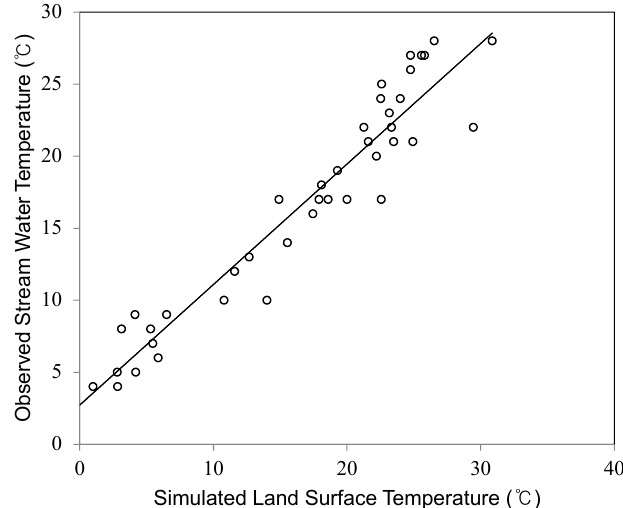
Figure 8. Comparison of trends between 1-km simulated land surface temperatures and observed stream water temperatures for the study basin in 2009.